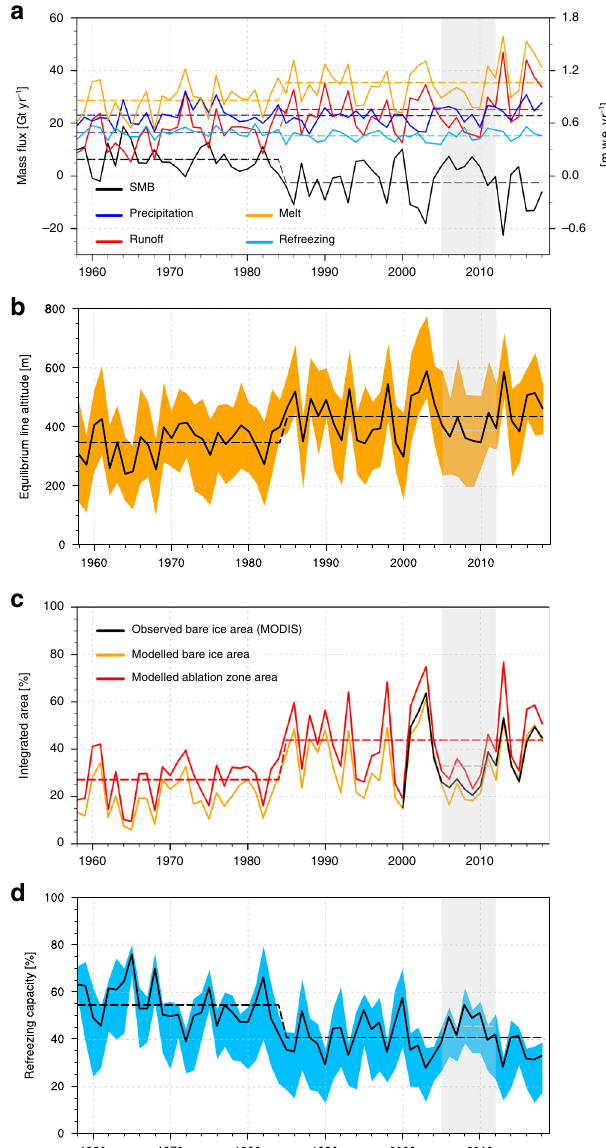
Fig. 3 Ablation zone expansion and reduced refreezing capacity. a Time series of annual SMB and components including surface melt, runoff, total precipitation, and refreezing for the period 1958 – 2018. b Time series of annual ELA for the whole of Svalbard (black) and individual sectors (Fig. 1a, orange band). c Time series showing the modelled ablation zone area, the modelled and observed (MODIS) bare ice area as a fraction of the total Svalbard land ice area (%). d Time series of annual refreezing capacity for the whole of Svalbard (black) and individual sectors (cyan band). Dashed lines show averages for the periods 1958 – 1984 and 1985 – 2018. The grey shade highlights the period 2005 – 2012 when Svalbard SMB temporarily returned to the pre-1985 SMB conditions. Dashed grey lines represent